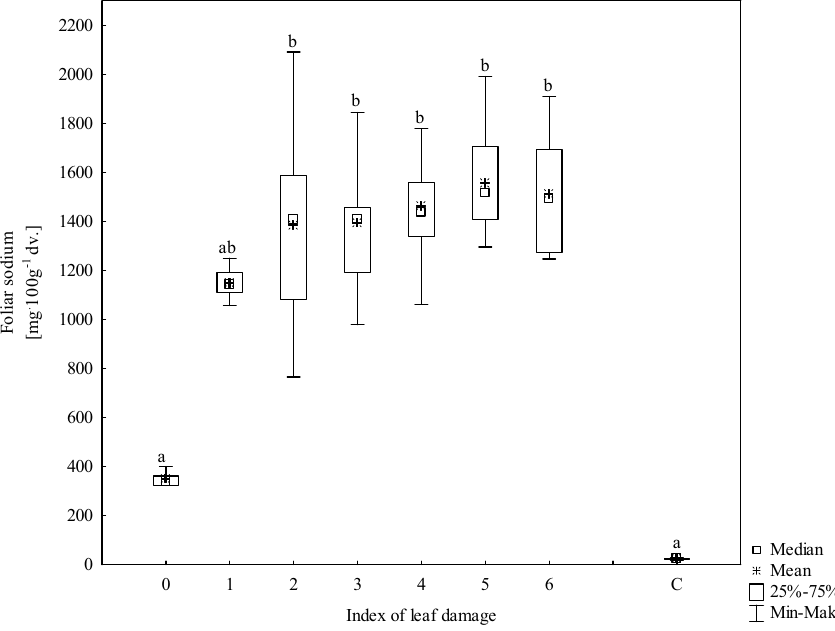
Figure 3. Sodium concentrations in foliage samples. C = park trees (control, n = 5), 0–6 = roadside trees (n = 10 per leaf damage severity). Results with the same letter are not statistically different (Kruskal–Wallis test, p < 0.05).